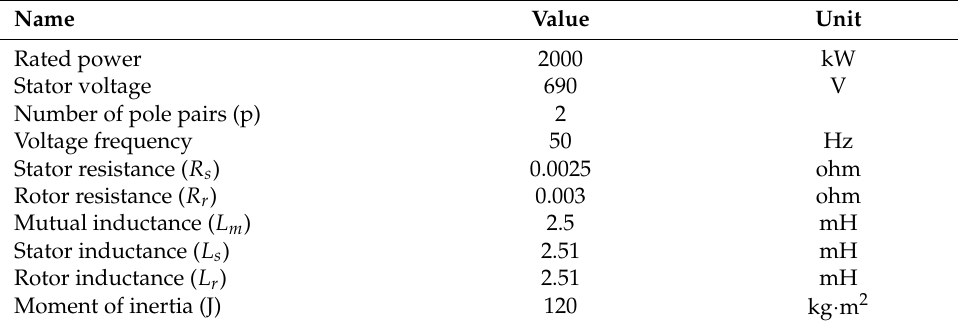
Table 1. DFIG parameters.